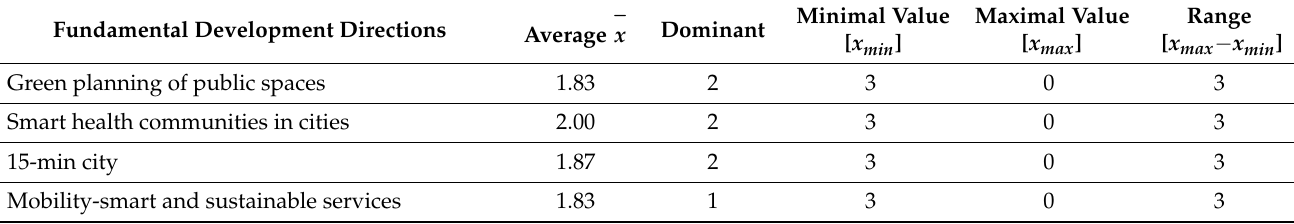
Table A1. Calculations of the descriptive statistics of the fundamental development directions of a smart city in Poland based on expert opinion. Source: Own